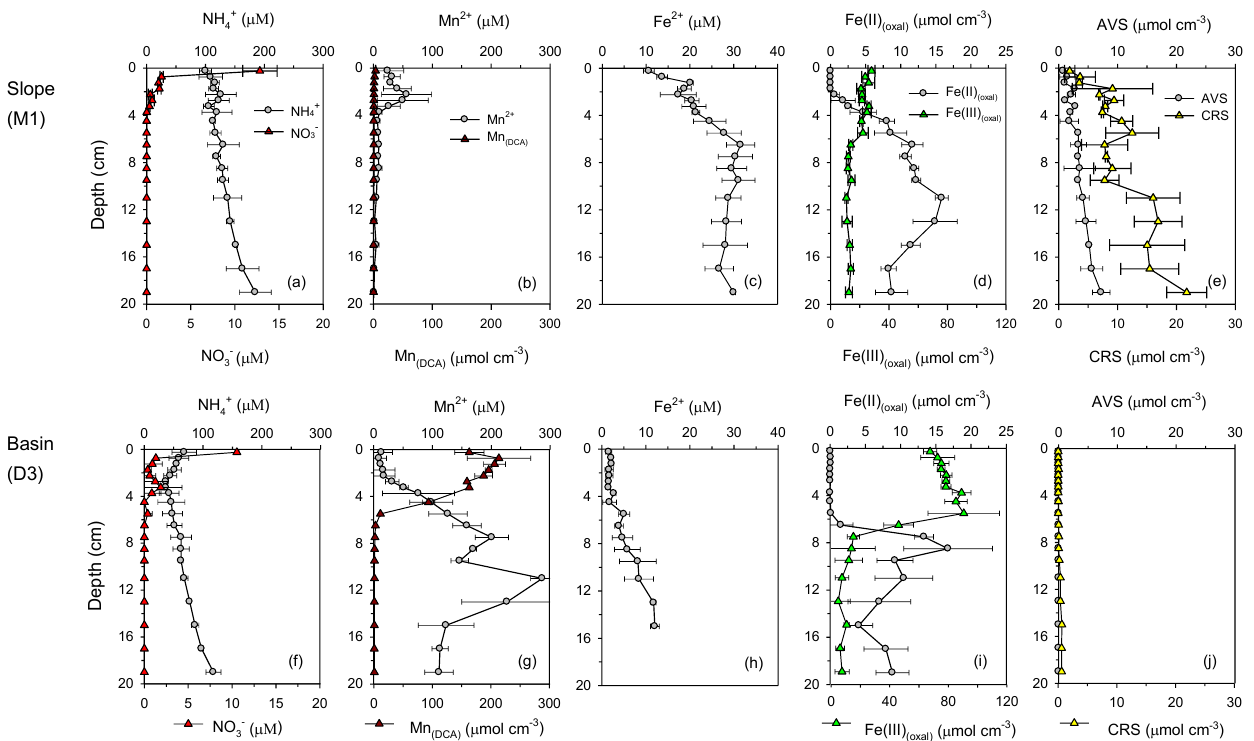
Figure 2. Concentrations of dissolved NH + Fe(III) (oxal) , acid-volatile sulfur (AVS), and chromium-reducible sulfur (CRS) in the sediment at M1 and D3.